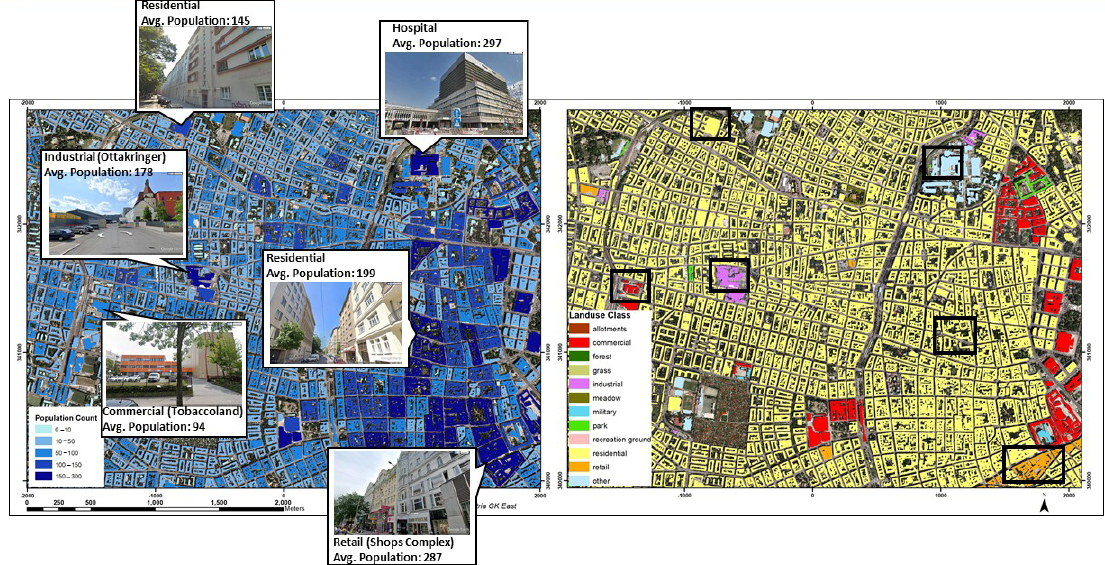
Figure 15. Evaluation of the results in the attribute extraction process with the help of Google Street View. (Average population values shown in the buildings of the left map are the values from the attribute extraction